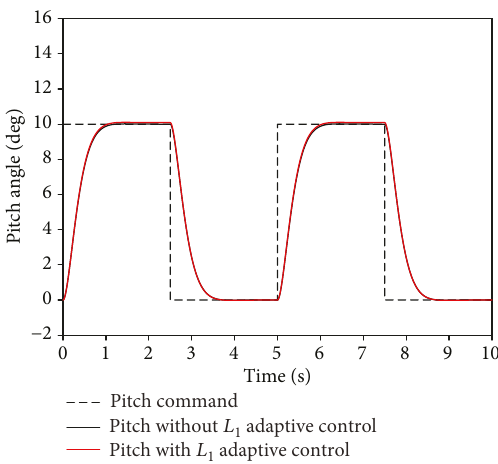
Figure 3: Pitch angle capture task without parameter